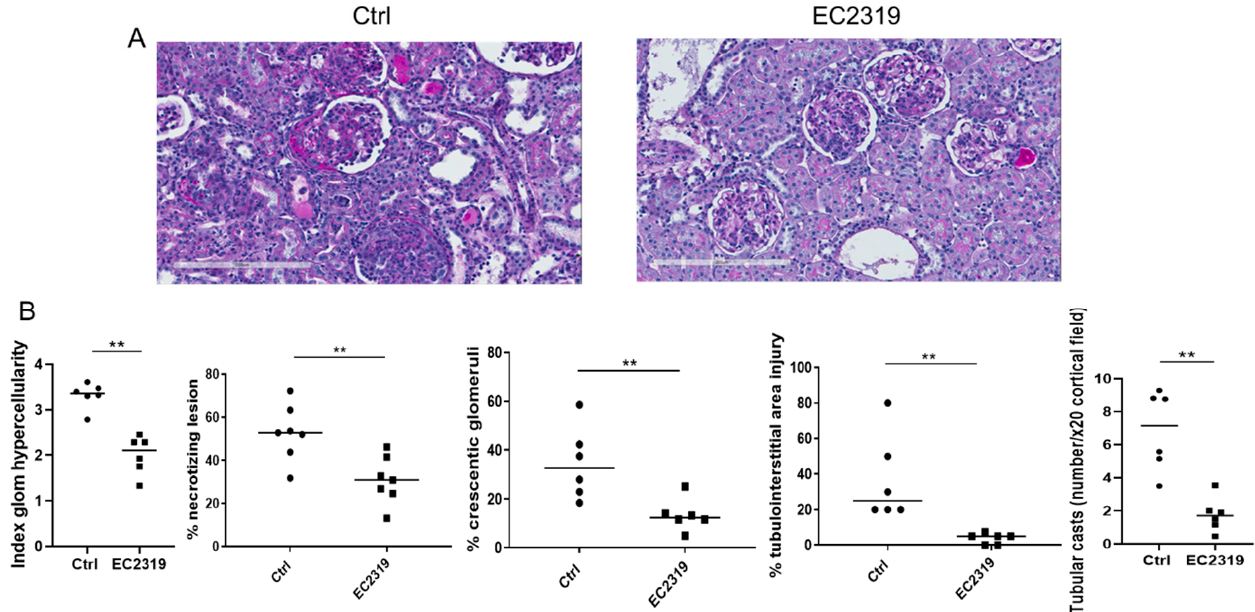
Figure 2. EC2319 attenuates kidney injury: ( A ) Periodic acid-Schiff (PAS) staining of kidney sections of WKY rats treated with vehicle or EC2319. Nephritic kidneys from vehicle-treated rats had severe lesions that were reduced in the EC2319 treated group. ( B ) Quantitation of kidney injury in control rats and EC2319-treated rats with anti-GBM GN. Results were sampled from six rats per group and expressed as mean ± SEM. ** p < 0.01. PAS staining, original magnification × 400. Control, EC2319.